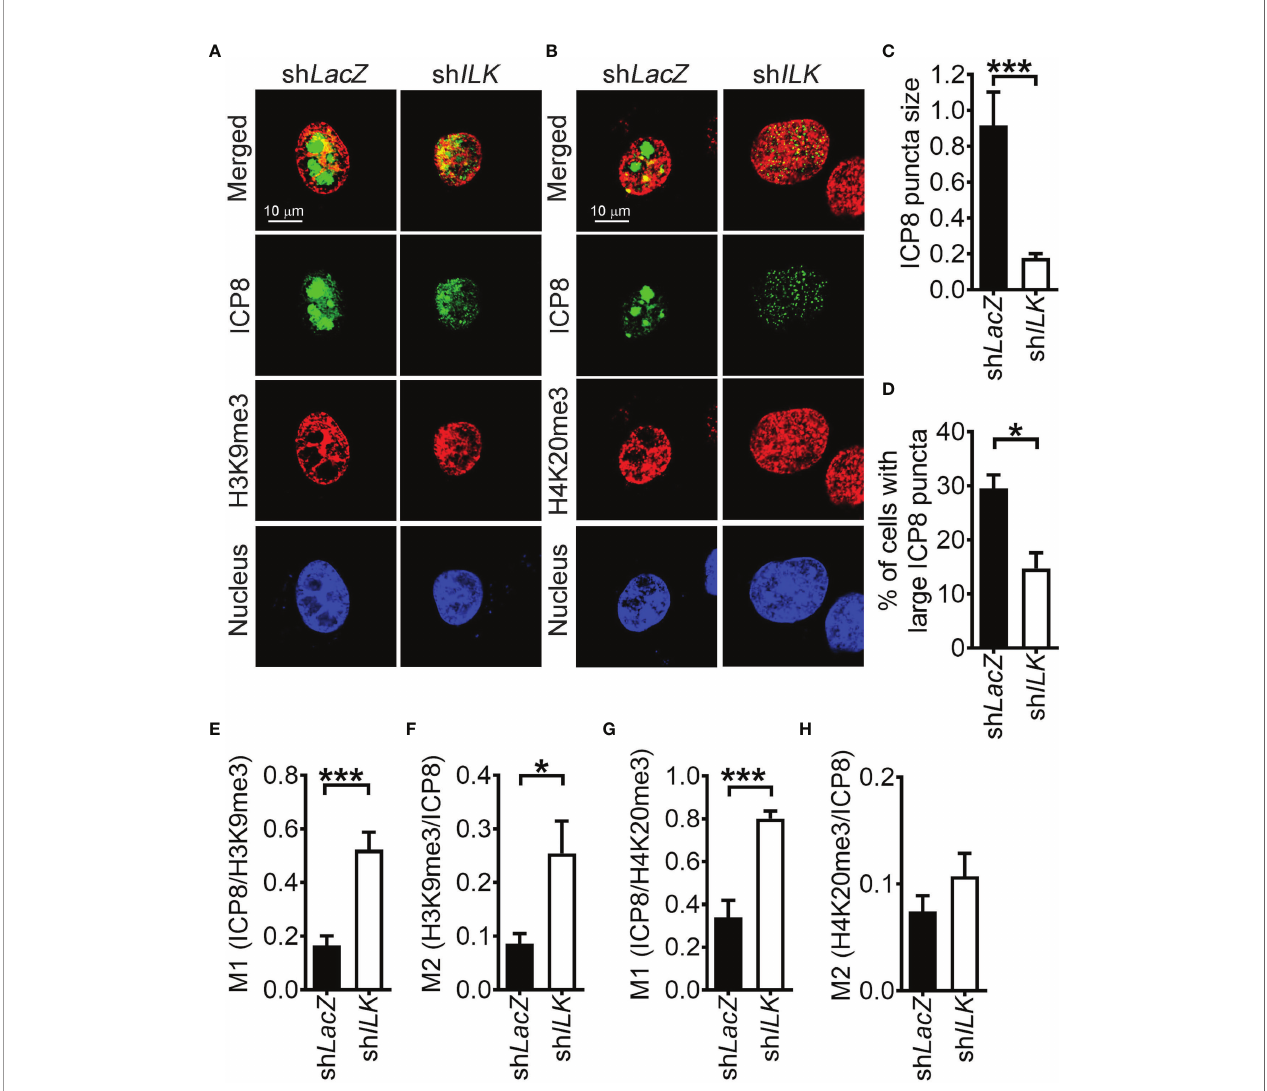
FIGURE 4 | ILK promotes heterochromatin mark exclusion from HSV-1 replication compartments. (A, B) The representative images of control (sh LacZ ) and ILK knockdown (sh ILK ) cells infected with HSV-1 for 6 hours and stained with antibodies against ICP8, H3K9me3, or H4K20me3 are shown. Cell nuclei are counterstained with DAPI. (C) The size of ICP8 puncta was measured by particle analysis of ImageJ software. (D) The percentage of ICP8-positive cells with large puncta was calculated from 3 independent experiments. (E – H) The colocalization ICP8 with H3K9me3 or H4K20me3 was quanti fi ed by the Jacob plugin of ImageJ software as Manders ’ coef fi cient M1 and M2. Data represent mean ± SEM (error bar). * p < 0.05, *** p < 0.001 via Student t